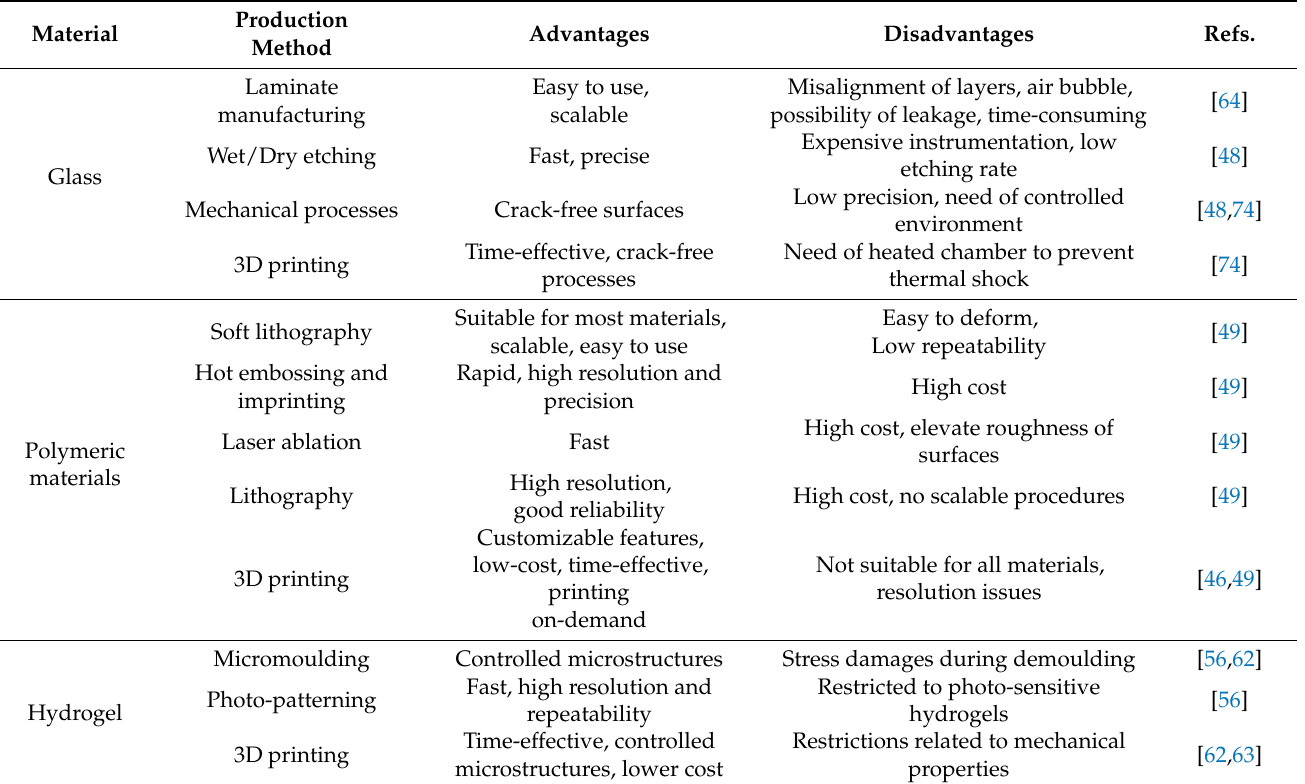
Table 2. Comparison regarding pros and cons of using traditional and 3D printing methods in MF device manufacturing.